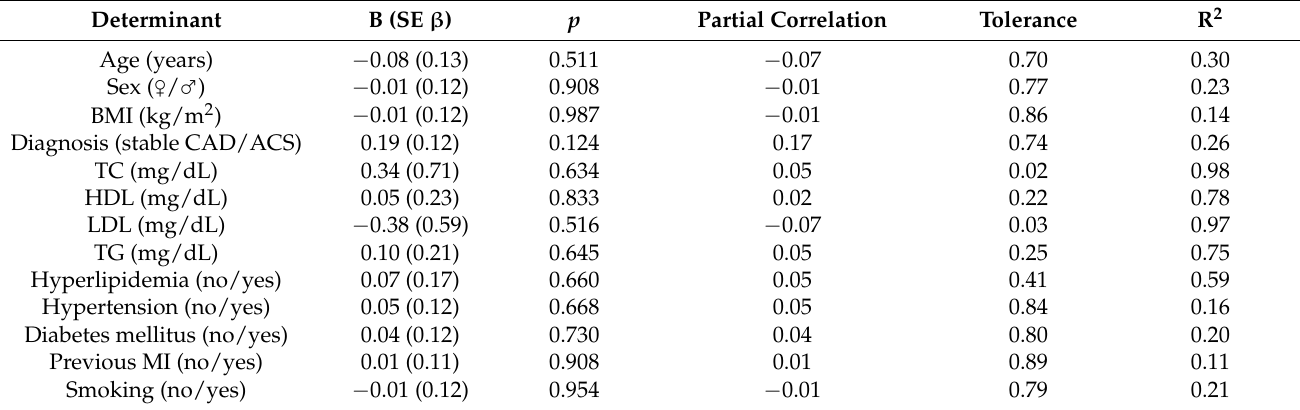
Table 4. Multivariable regression analysis for